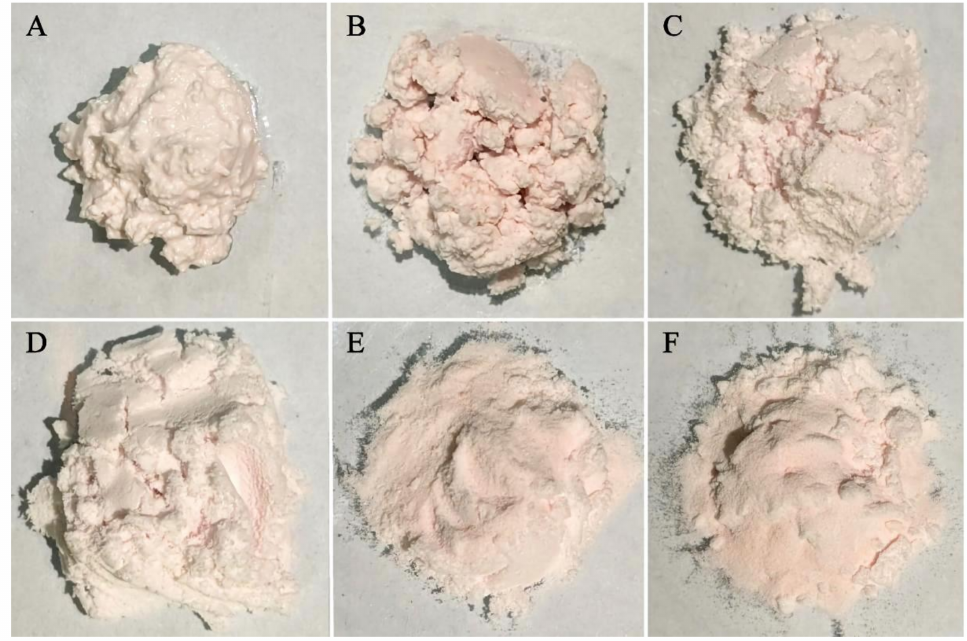
Figure 6. Sample photos of MnSO 4 • H 2 O after washing with different ethanol ratios: 0% ( A ), 40% ( B ),